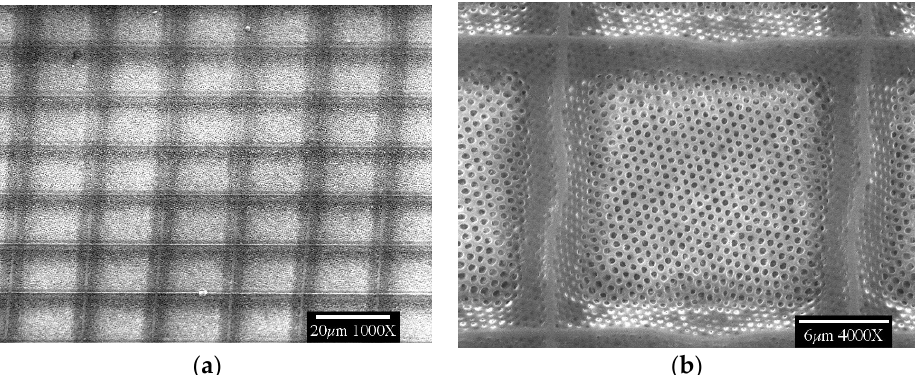
Figure 5. Delaminated IL patterned structures ( a ) and 2PL patterned structures ( b ) during the development.